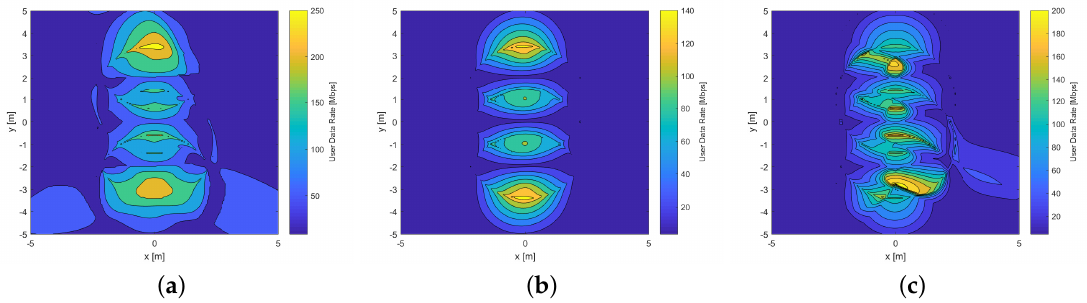
Figure 9. UDR distribution of the hemi-dodecahedron ADR in the mining roadway scenario: ( a ) MRC, ( b ) EGC, and ( c ) SBC